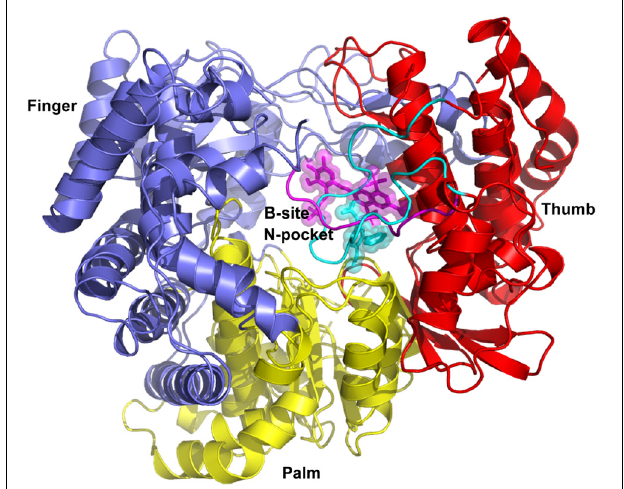
FIGURE 1 | Superimposition of complex structures of DENV-RdRp/JF-31-MG46 (PDB ID 5F3T) and hNV-RpRp/PPNDS (PDB